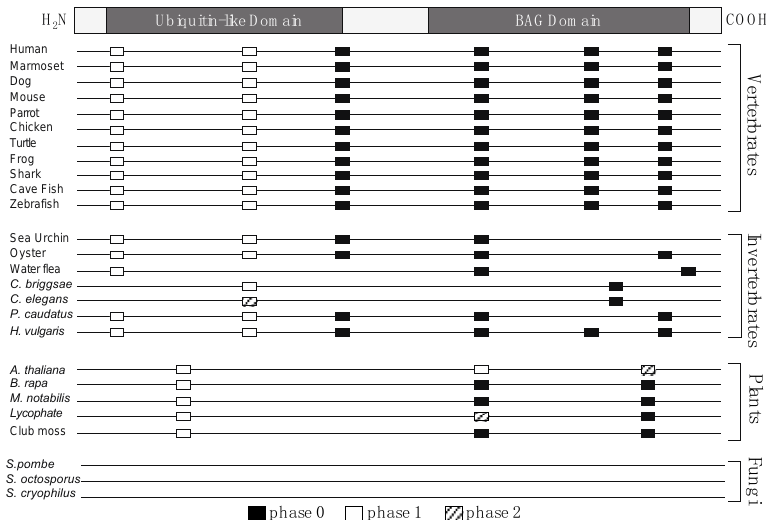
Figure 5. Conservation of intron position and phase reveals orthology within — and potentially between — animals, plants, and fungi. The figure depicts the position and phase of introns within BAG1 genes from representative species in each kingdom. Intron position and phase were determined by aligning genomic sequences and coding sequences for each BAG1 ortholog using Spidey (Wheelan et al., 2001).